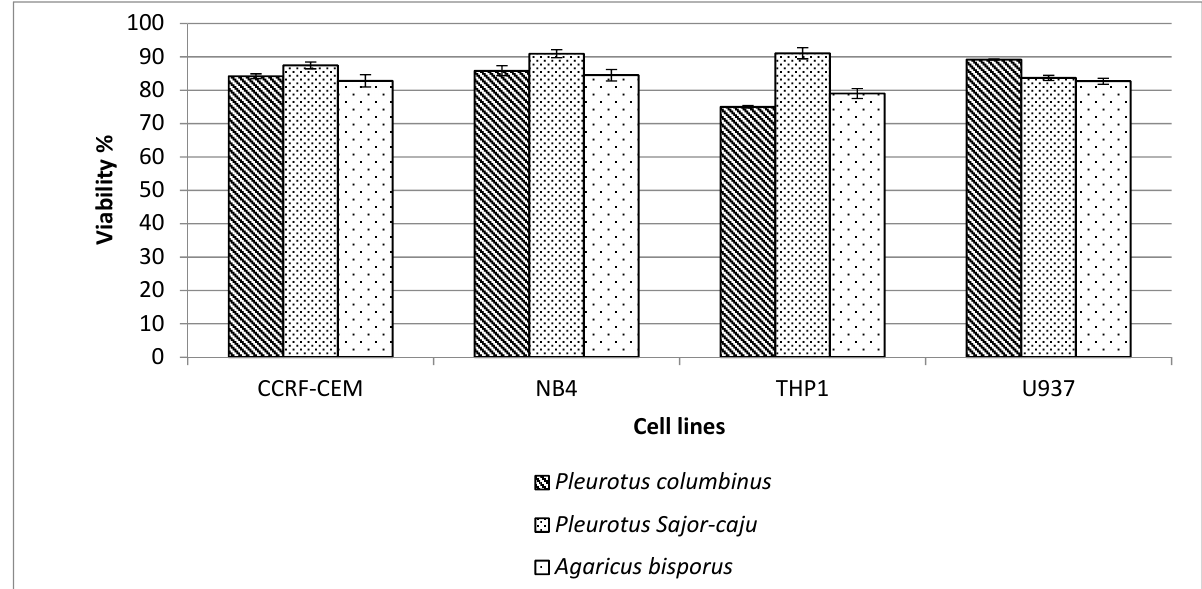
Figure 4. Cell viability of the three mushrooms extracts Pleurotus columbinus , Pleurotus sajor-caju , and Agaricus bisporus against leukemic cells (CCRF-CEM, NB4, and THP1) and lymphoma U937.